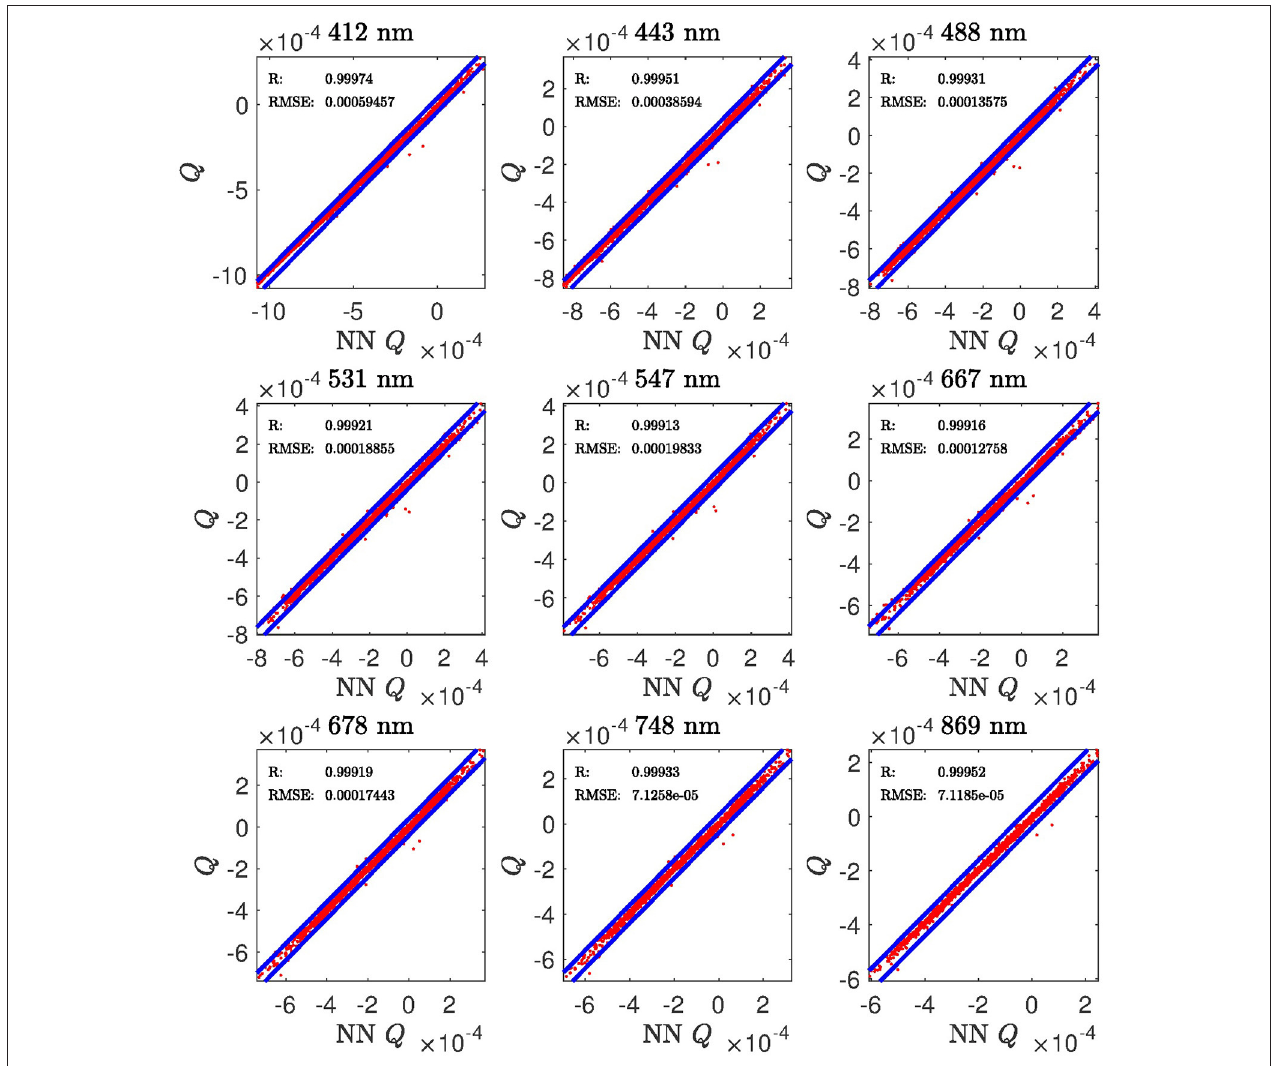
FIGURE 3 | Comparison of RBF-NN forward model results for Q with C-VDISORT results for the nine MODIS VIS channels used in this study.